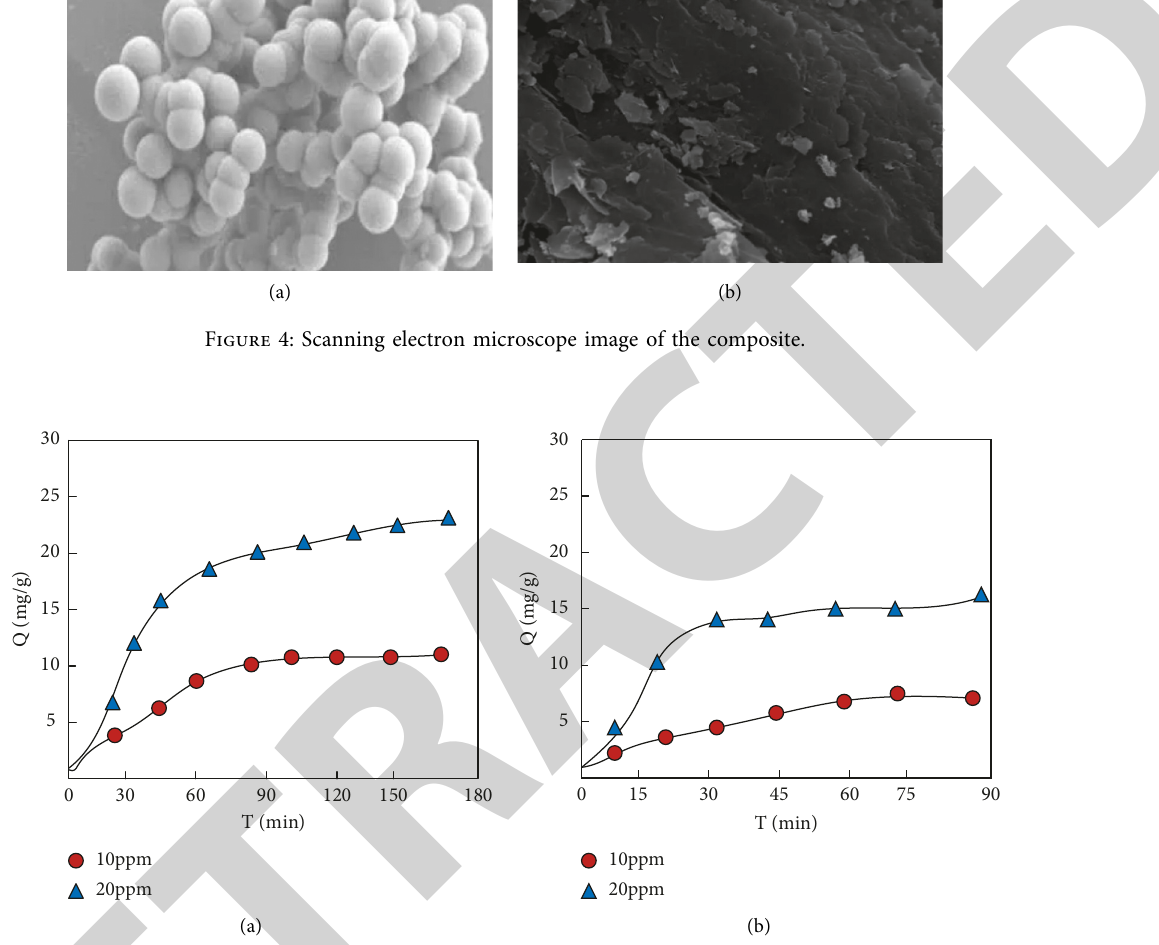
Figure 5: Variation curve of adsorption performance of composites for different heavy metal ions with time at different initial con- centrations: (a) variation of adsorption performance with time from 0 to 180min and (b) variation of adsorption performance with time for 10–80min.